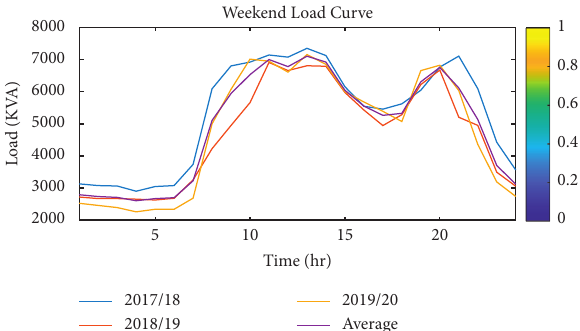
Figure 8: Weekend days hourly average load profile in